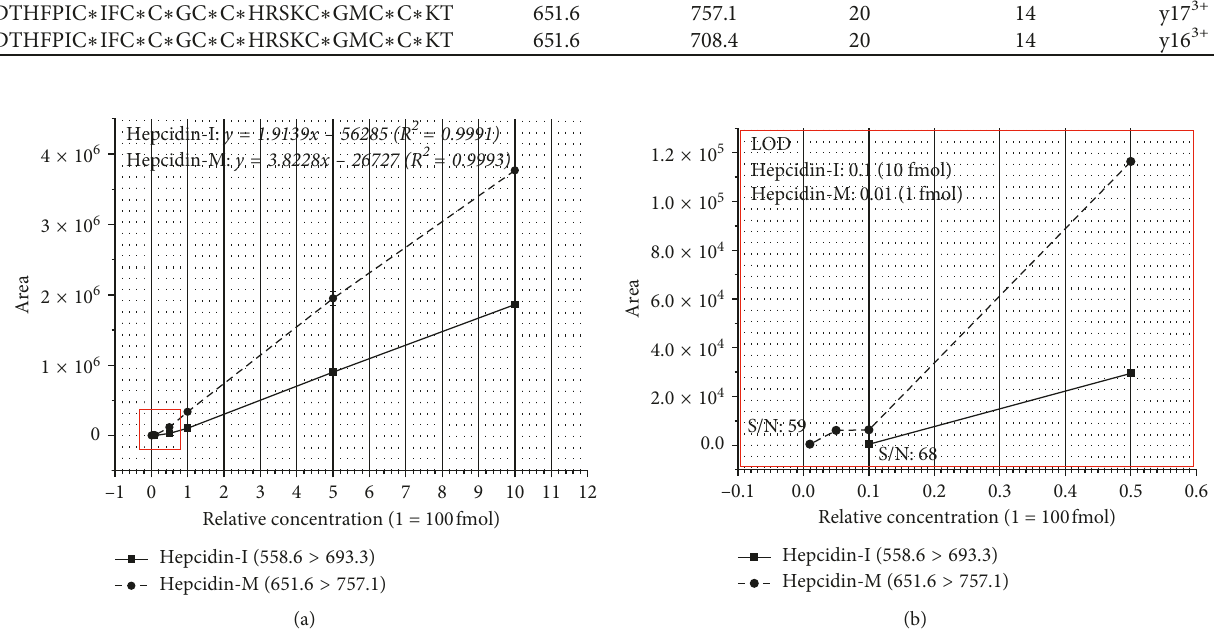
693.3 and 651.6 757.1 of transitions, respectively. (a) R2 of hepcidin-I and -M 1.9139 x 56285 and y 3.8228 x 26727, respectively. (b) An enlarged graph of the red box portion in (cid:31) (cid:31) > > − −